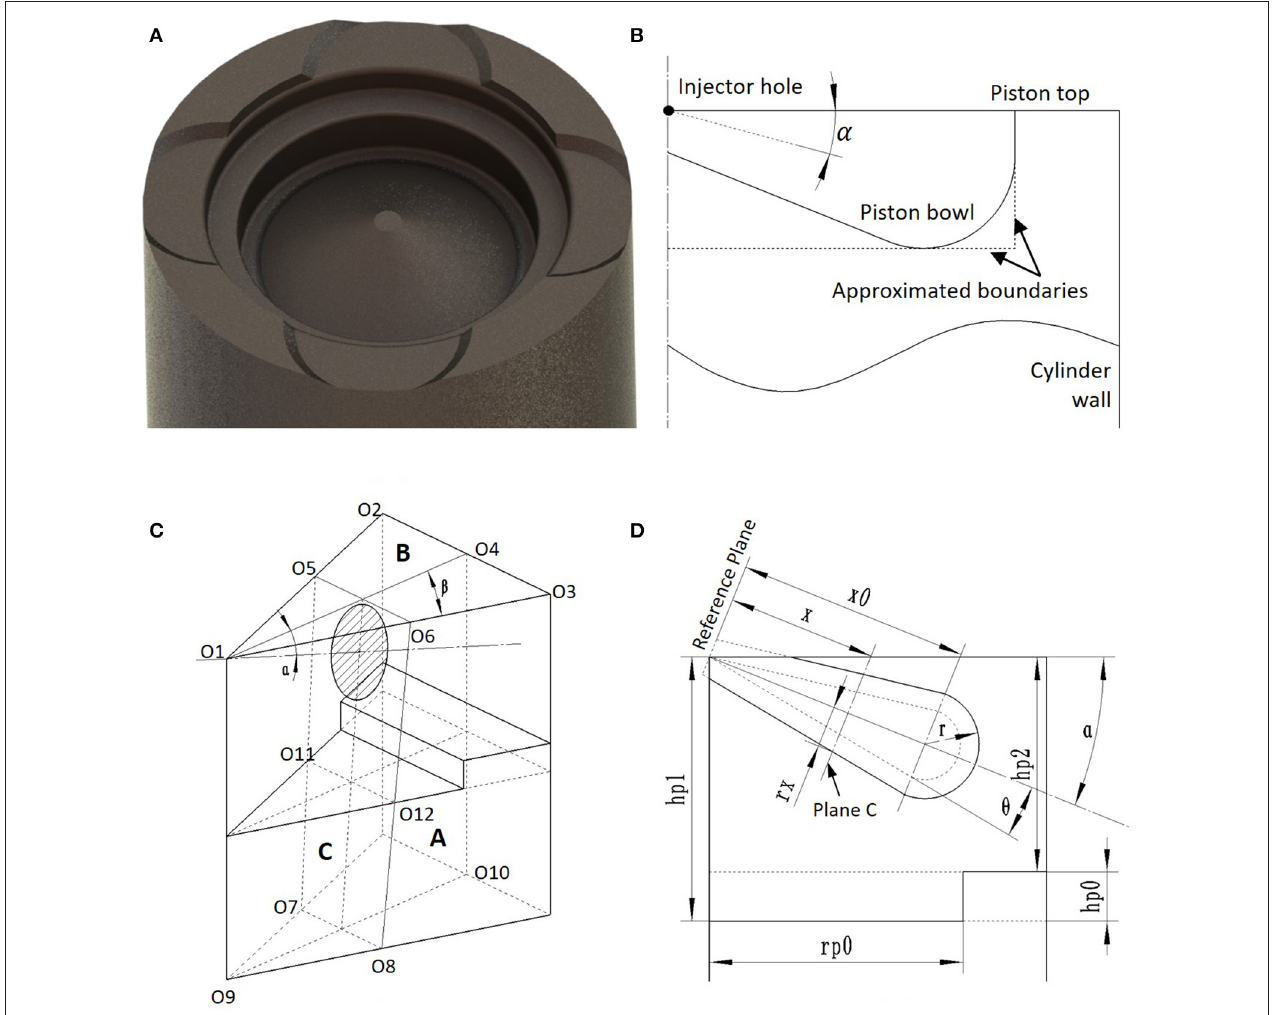
FIGURE 5 | (A) Geometry of the piston from the engine used in this work. (B) Approximation of the piston geometry on a 2-D plane. (C) 3-D illustration of geometrical framework of the flame geometry model. (D) Further illustration of geometrical framework in a 2-D plane.